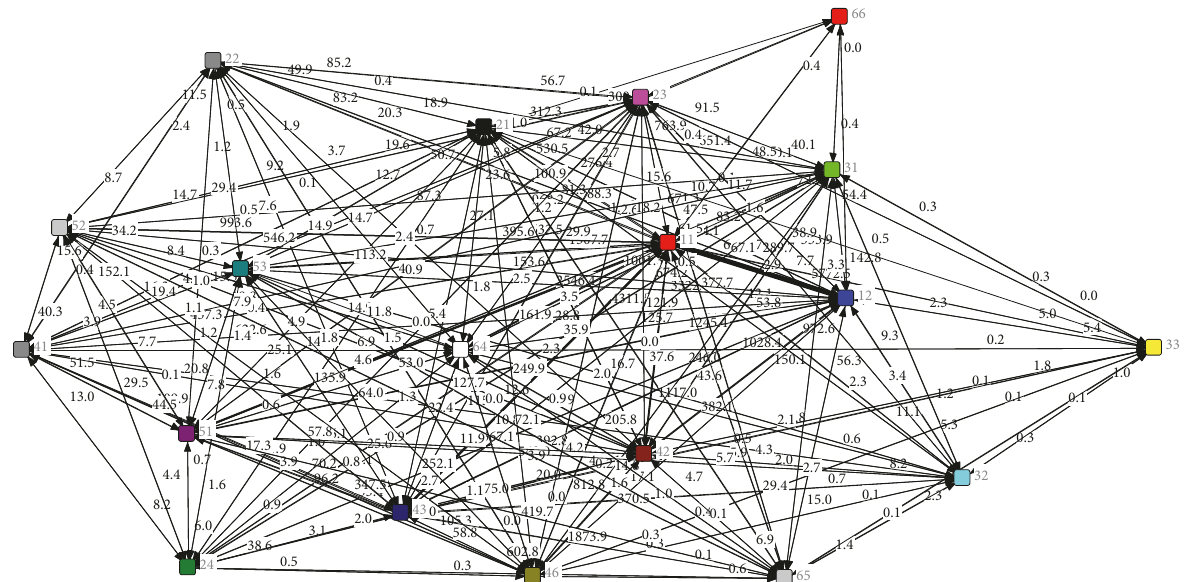
Figure 8: The topology of land system networks showing the conversions among land cover types in 1990–1995.